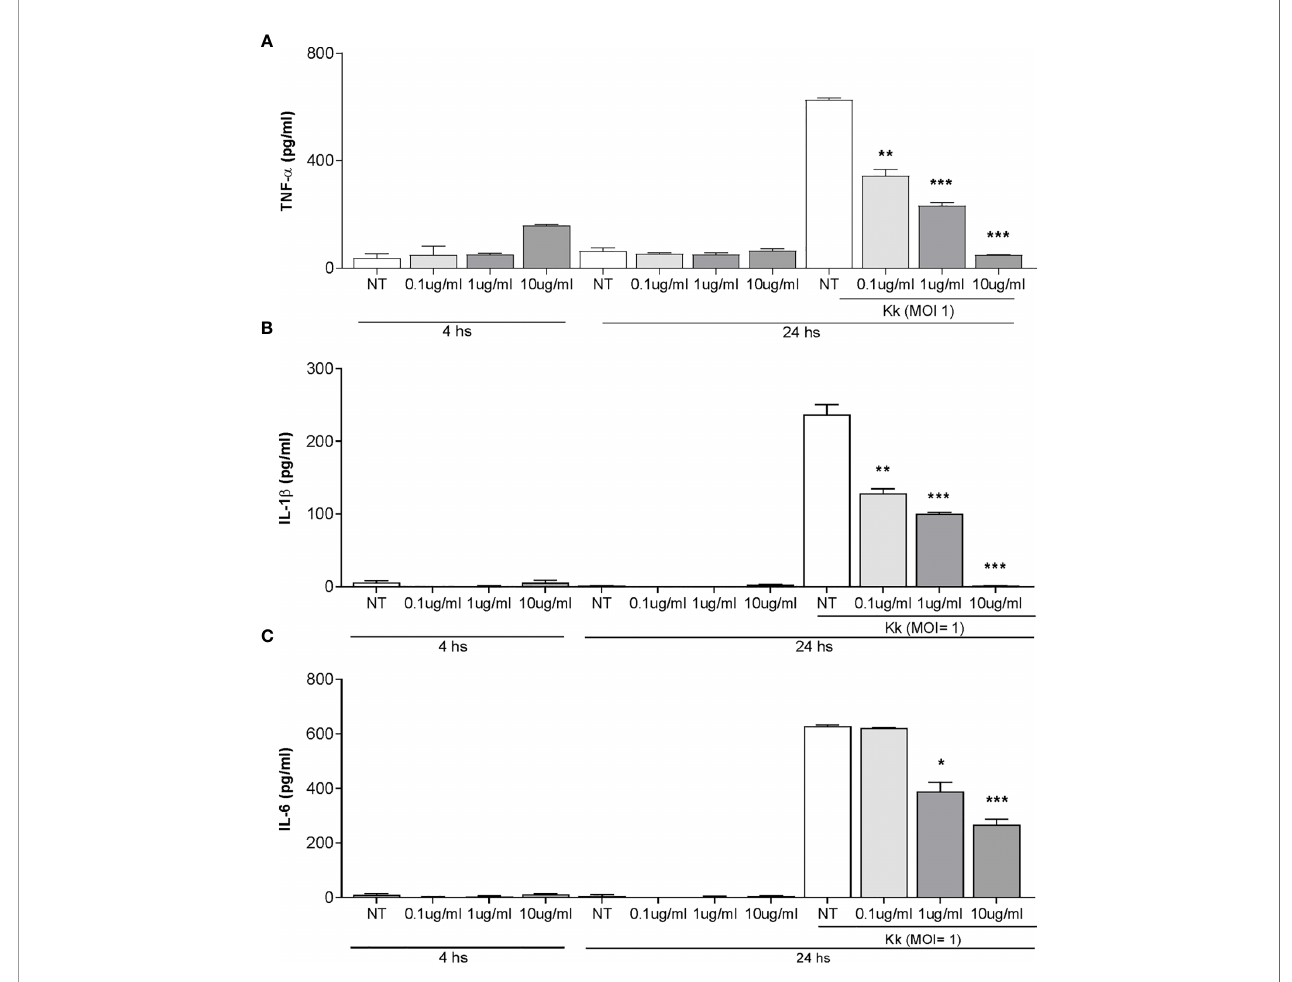
response monocytes to K. kingae infection.